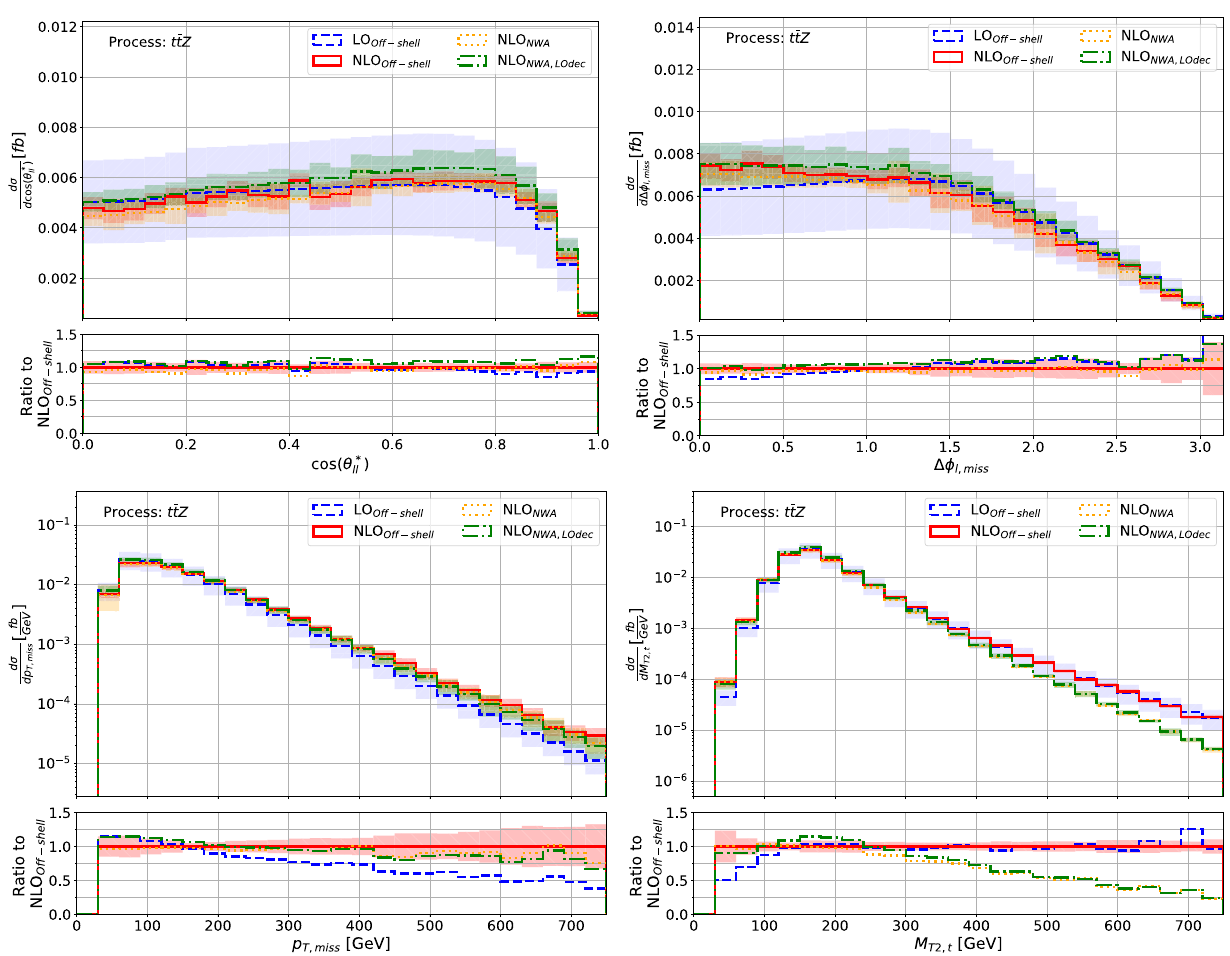
√ s = 13 TeV. The error